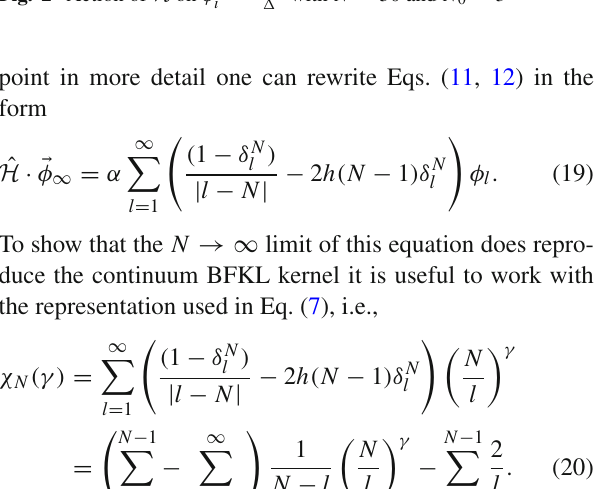
Fig. 2 Action of ˆ H on φ 0